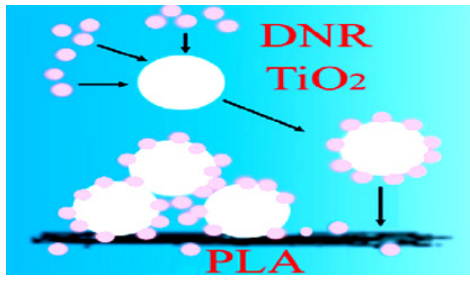
Fig 6. Scheme of the probable procedure for the self- assembly and accumulation of the DNR drug on the PLA/ TiO 2